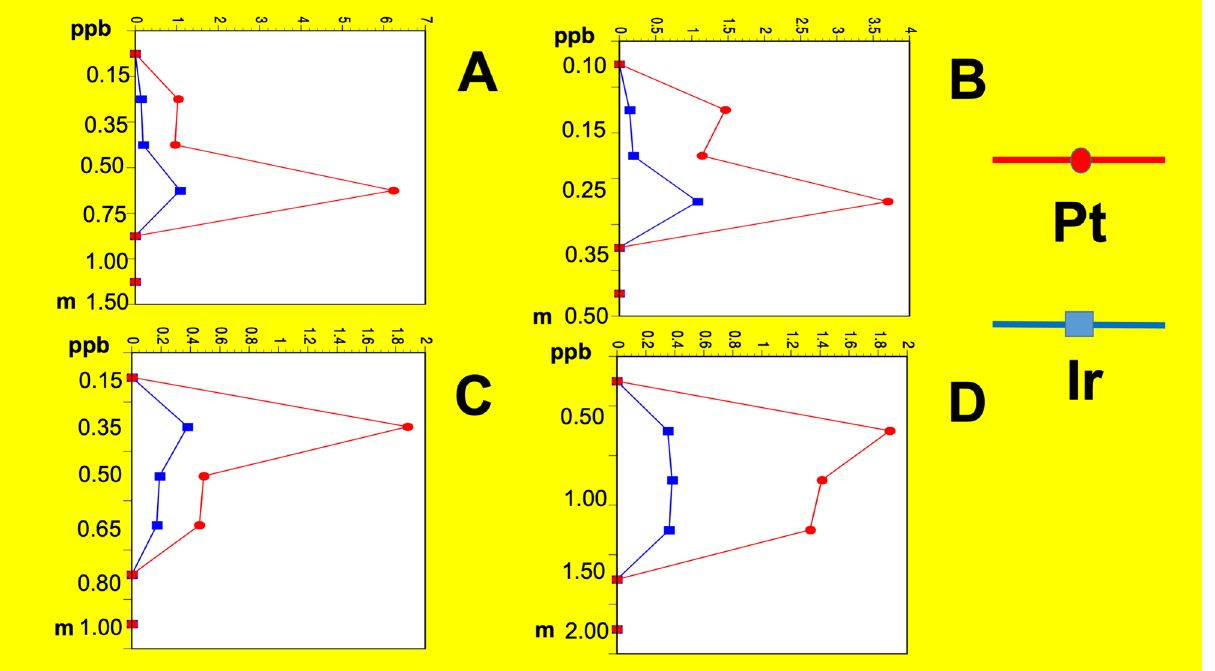
Figure 17. Positive Ir and Pt anomalies from the burned carbon-rich strata on Hopewell archaeological sites in the Ohio River valley: ( A ) Turner earthworks and village, Ohio; ( B ) Moundview village and mound, Ohio; ( C )